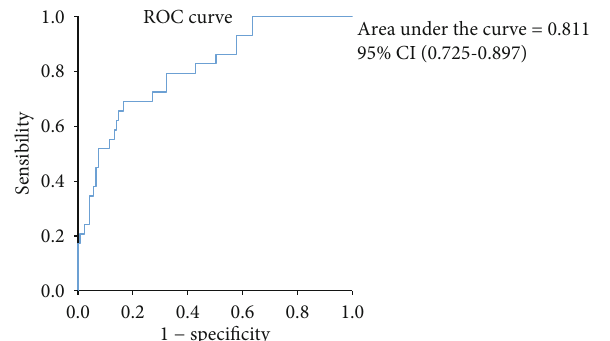
Figure 5: ROC curve for the RP-ILD risk prediction model. ROC curve analysis was used to assess the diagnostic value of sCD206 levels in the prediction of RP-ILD. The area under the curve was 0.811 ( p < 0 : 0001 ), and the optional cut-o ff value was 792.75ng/ml with a sensibility of 0.690 and a speci fi city of 0.835. ROC: receiver operating characteristic; RP-ILD: rapidly progressive interstitial lung disease; sCD206: soluble